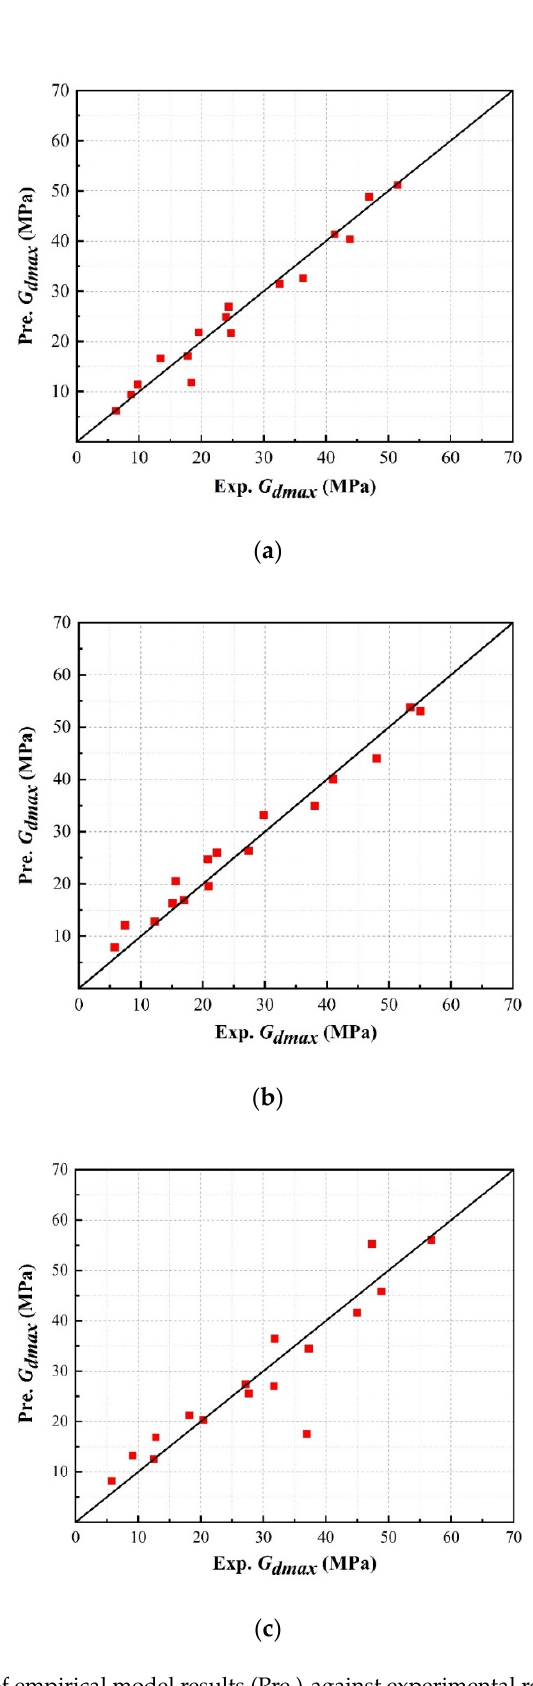
Figure 19. Validation of empirical model results (Pre.) against experimental results (Exp.) for different rubber particle sizes: ( a ) SRP1; ( b ) SRP2; ( c ) SRP3.